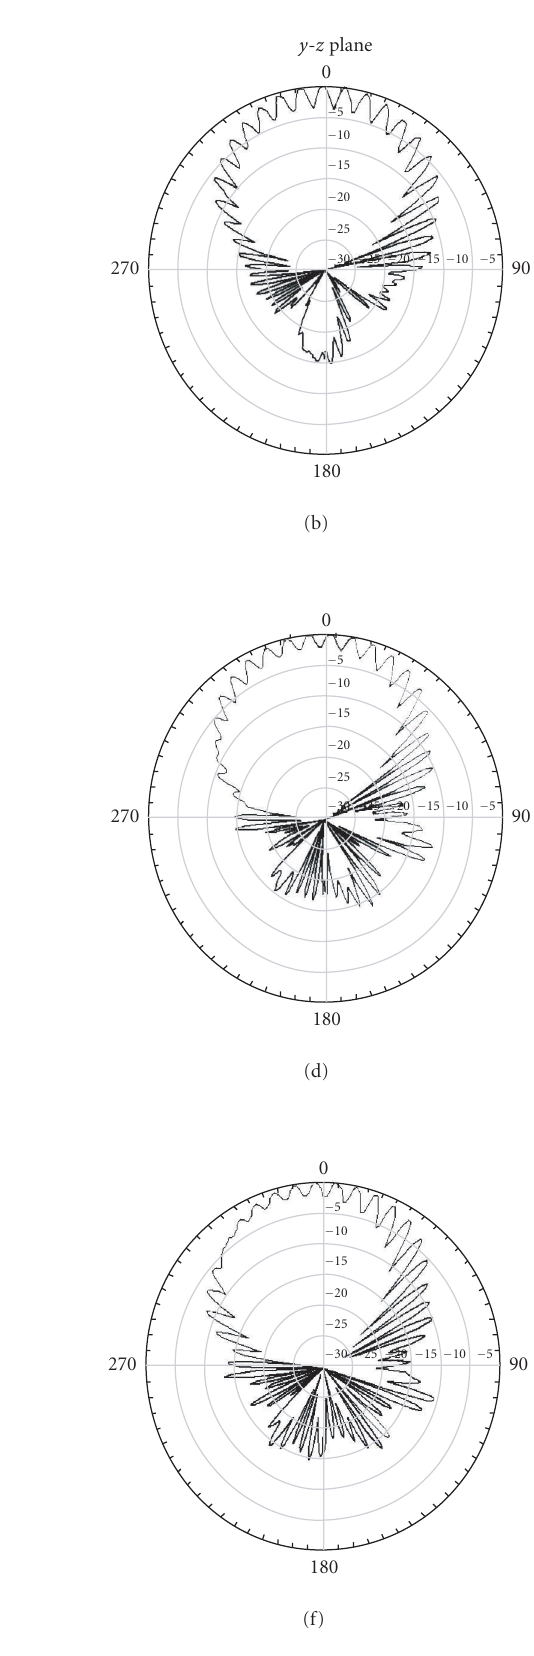
Figure 5: Measured radiation patterns of the proposed